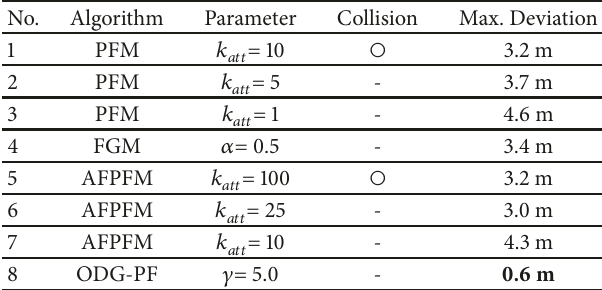
Table 1: Experimental results of static obstacle